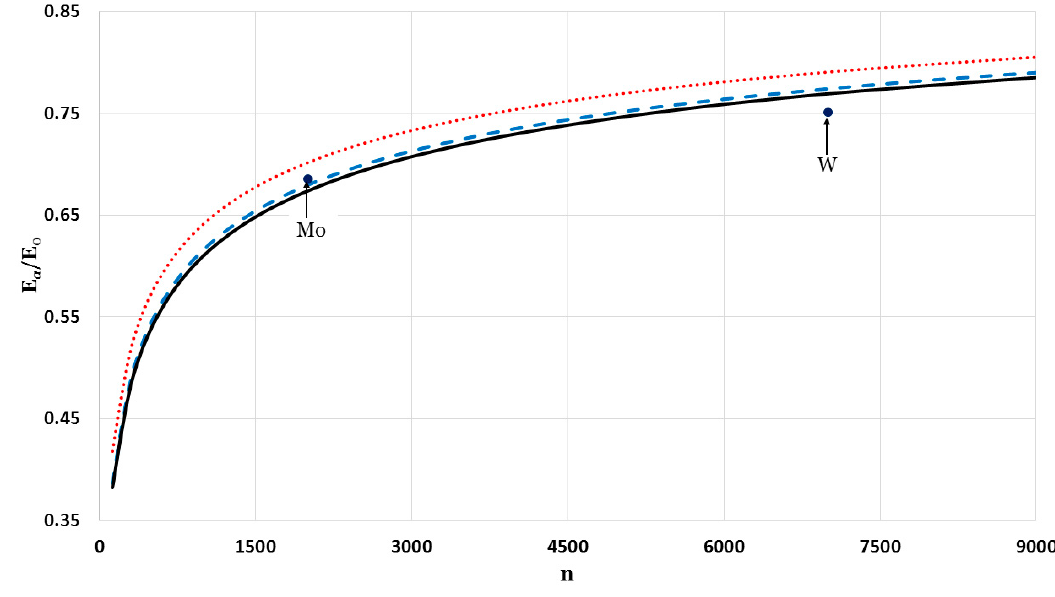
Figure 14. The variation of the relative cohesive energy as function of the number of atoms (where m = 2 and α = 2.4) for different cubic structures of nanoparticles: A body-centered cubic structure (black solid line), a face-centered cubic structure (blue dashed line), and a simple cubic structure (the red dotted line). The experimental values [23,24] are denoted by dark blue circles.